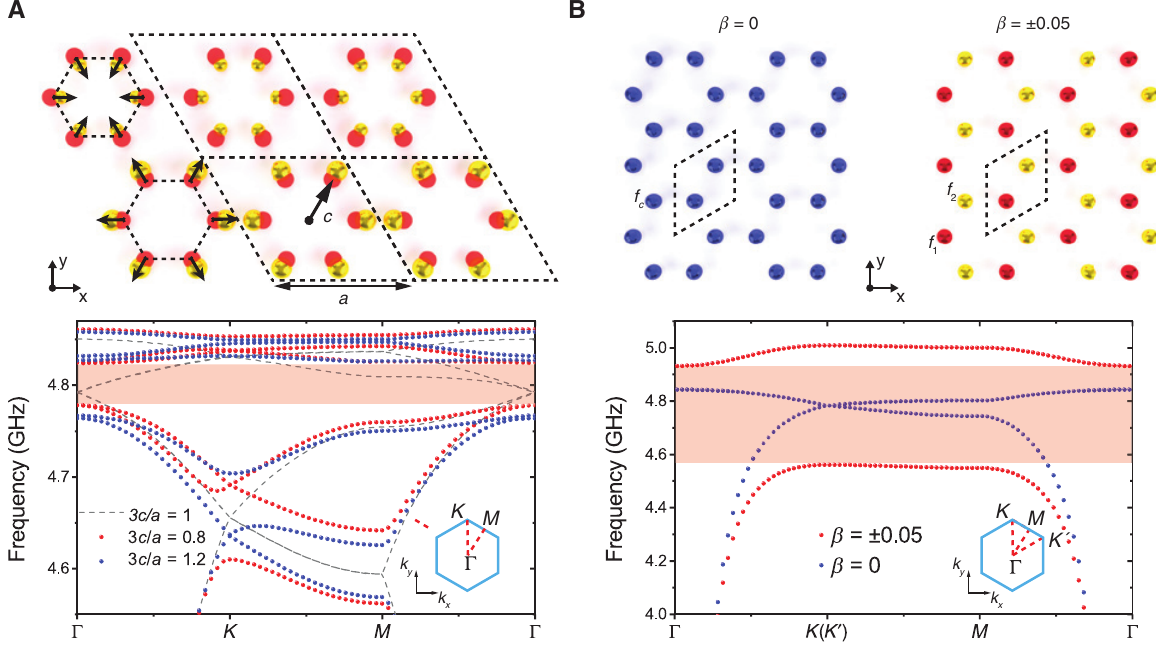
Figure 1: The schematics and corresponding numerical band structures for metamaterial topological insulators (TIs) considered in this work. Metamaterial TI based on (A) C6 symmetry and (B) valley conservation. In the top panels, the colored disks represent the spatially local resonators composing the metamaterial crystals. These resonators are assumed to be quarter-wavelength copper rods standing on a ground plane and oriented along z (the figure view is from the top), corresponding to a microwave implementation of local resonant metamaterials, whose structure is effectively subwavelength in the xOy plane. The bottom panels represent the associated numerical band structures obtained from full-wave numerical